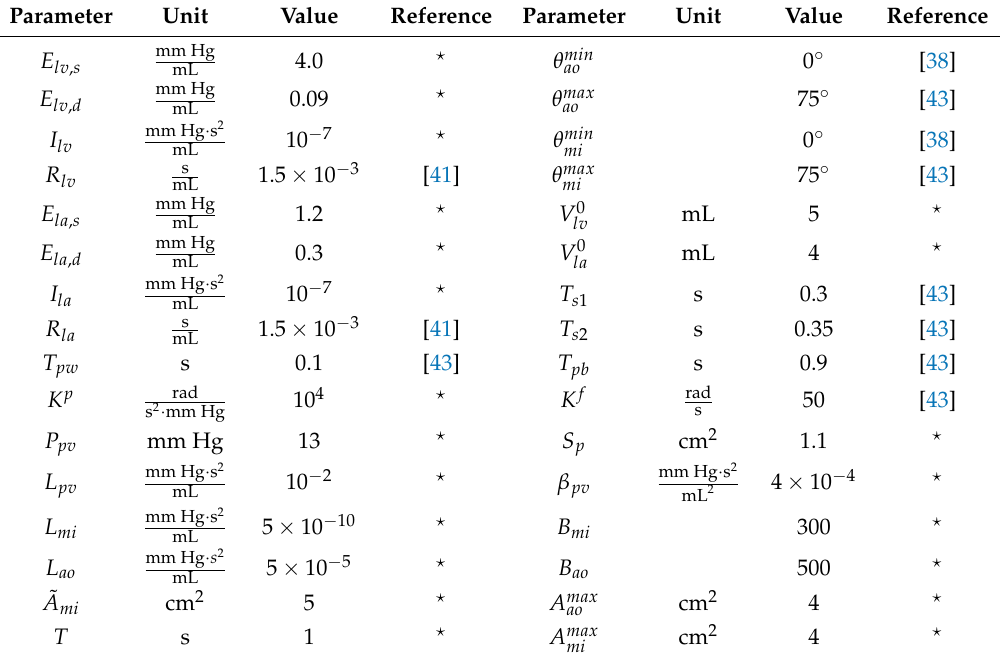
Table 4. Parameters of the lumped model of the left heart. (cid:63) Parameter is set manually.